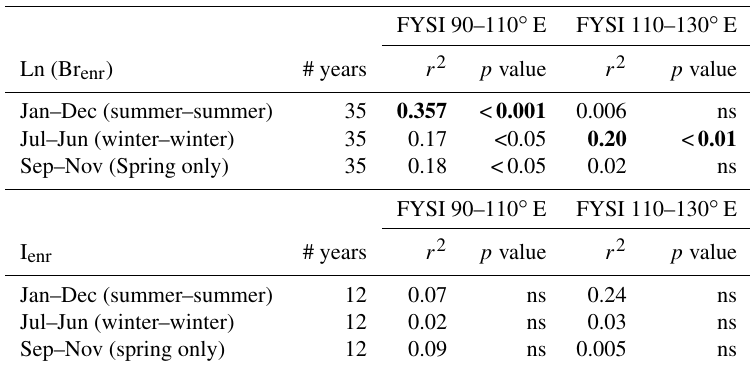
Table 2. Correlations between bromine and iodine enrichments and first-year sea ice (FYSI) areas calculated for two sectors adjacent to Law Dome. Correlations that are significant at the 99% level or above are shown in